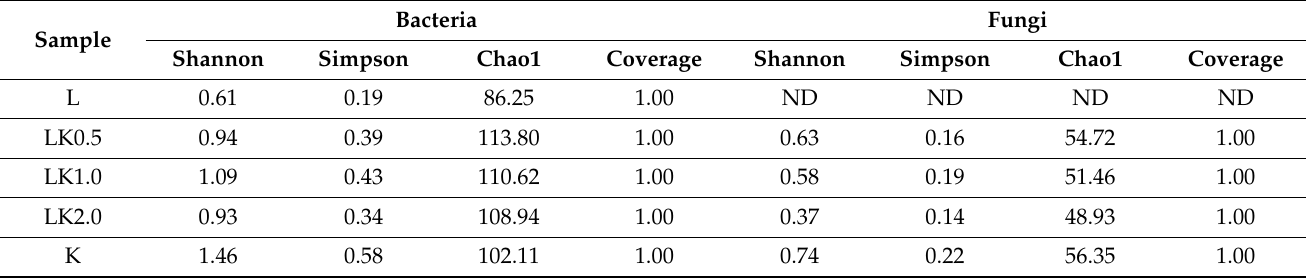
Table 2. Bacterial and fungal diversity